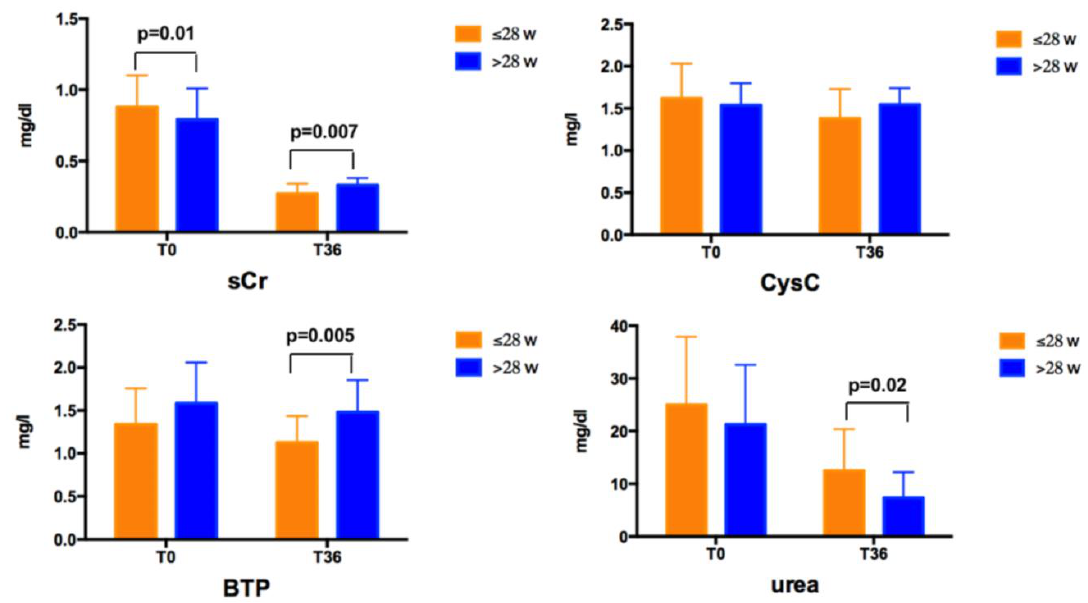
Figure 1. Serum Creatinine (sCr), Cystatine C (CysC), Beta-Trace Protein (BTP) and urea levels at T0